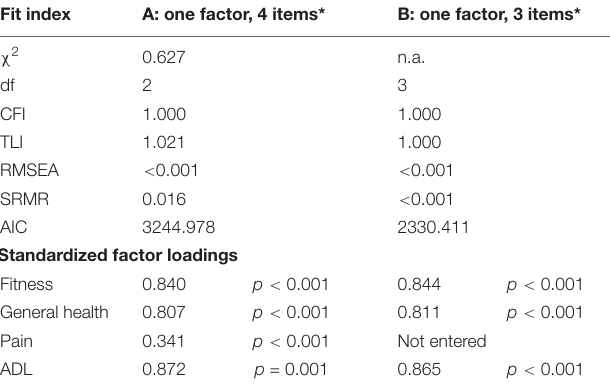
TABLE 1 | Clinical and demographic characteristics ( N = 94). TABLE 2 | Fit indices for models tested via confirmatory factor